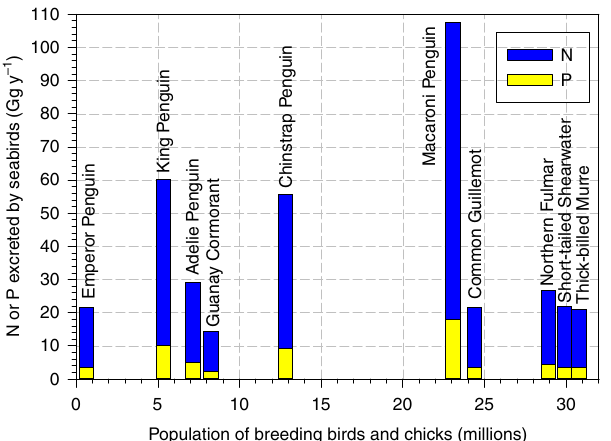
Fig. 3 The ten seabird species excreting the most N and P on a global scale relative to population size. The relevance of seabirds species in terms of N and P fl uxes from marine to continental environments (breeding colonies) depends on a number of factors, such as population size, corporal weight, length of the breeding season, or type of feeding and, hence, their contribution is very uneven. Penguins are the main contributors, fundamentally because of their high body mass (height: 70 – 130 cm; weight: 5 – 40 kg) and the long period of time they remained in the colony (more than one year), whereas the contribution of smaller species such as the Common Gillemot, Northern Fulmar, Short-tailed Shearwater, or Thick- billed Murre is a consequence of their large population Greenland, where colonies of more than one million individuals occur. The lowest N and P depositions are by members of the order Pelecaniformes, whose main species were the Guanay − 1 , 2.4 Gg Cormorant ( Phalacrocorax bougainvilliorum , 14 Gg N y P y − 1 ), and the Great Cormorant ( Phalacrocorax carbo , 6.7 Gg N − 1 − 1 and 1.1 Gg P y ). The Guanay Cormorant includes y approximately 8 million breeders and chicks in diverse colonies, which is found mainly along the Paci fi c coast of Peru and Northern Chile. The Great Cormorant is widely distributed, being found on every continent, except South America and Antarctica.